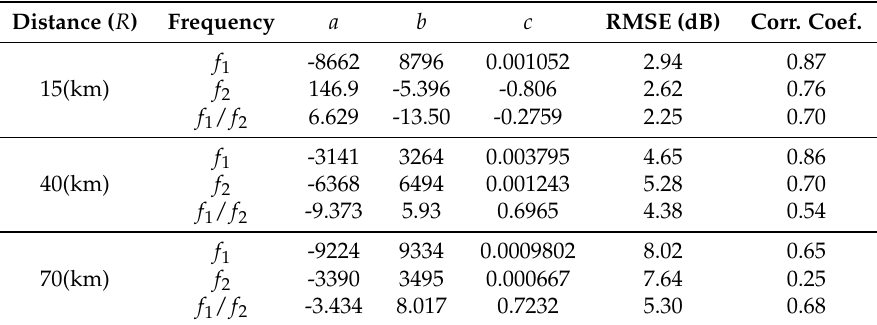
Table 2. Statistics of fitting Bragg power to wave height at different